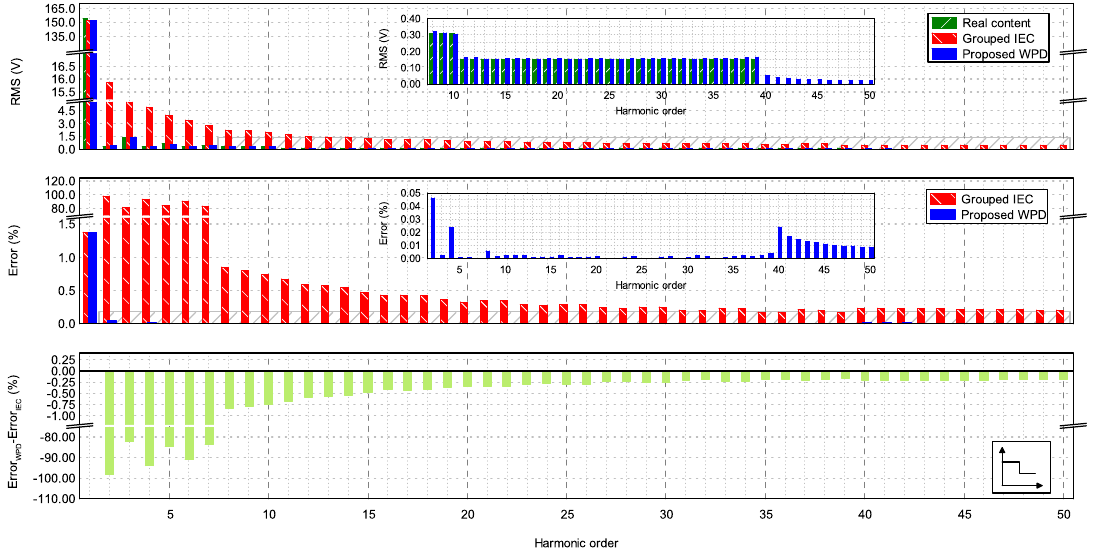
Figure 6. Analysis of the IEC 61000-3-2 limits waveform under non-stationary conditions (constant modulation). The upper graph shows the spectrum of the RMS content of each IEC frequency band for the three methods, compared to the real content. The middle graph shows the errors for each frequency band. The difference between the errors is shown in the bottom